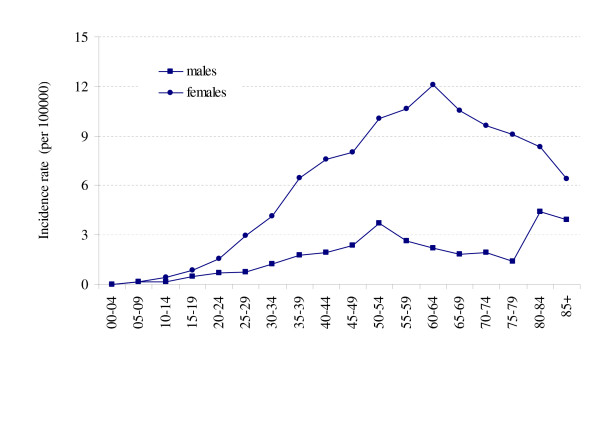
Age-specific thyroid cancer incidence rates in Lithuania, 1978–2003.